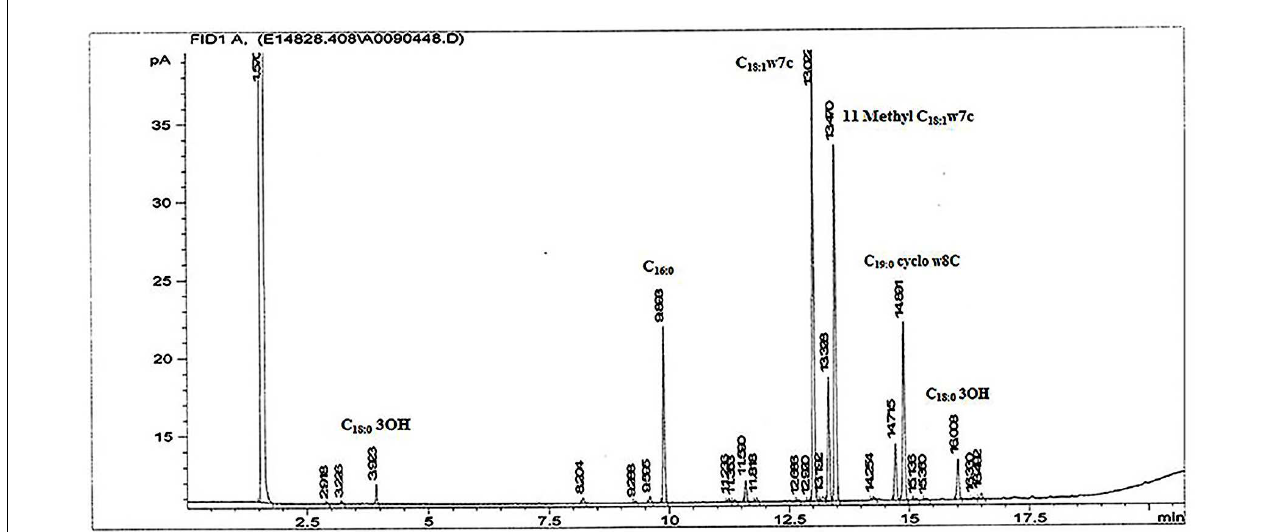
FIGURE 4 | The fatty acid methyl ester profile of isolate 17-2-E-8 using GC-FAME. Peaks were identified on the basis of their retention times using BAME (bacterial methyl ester)